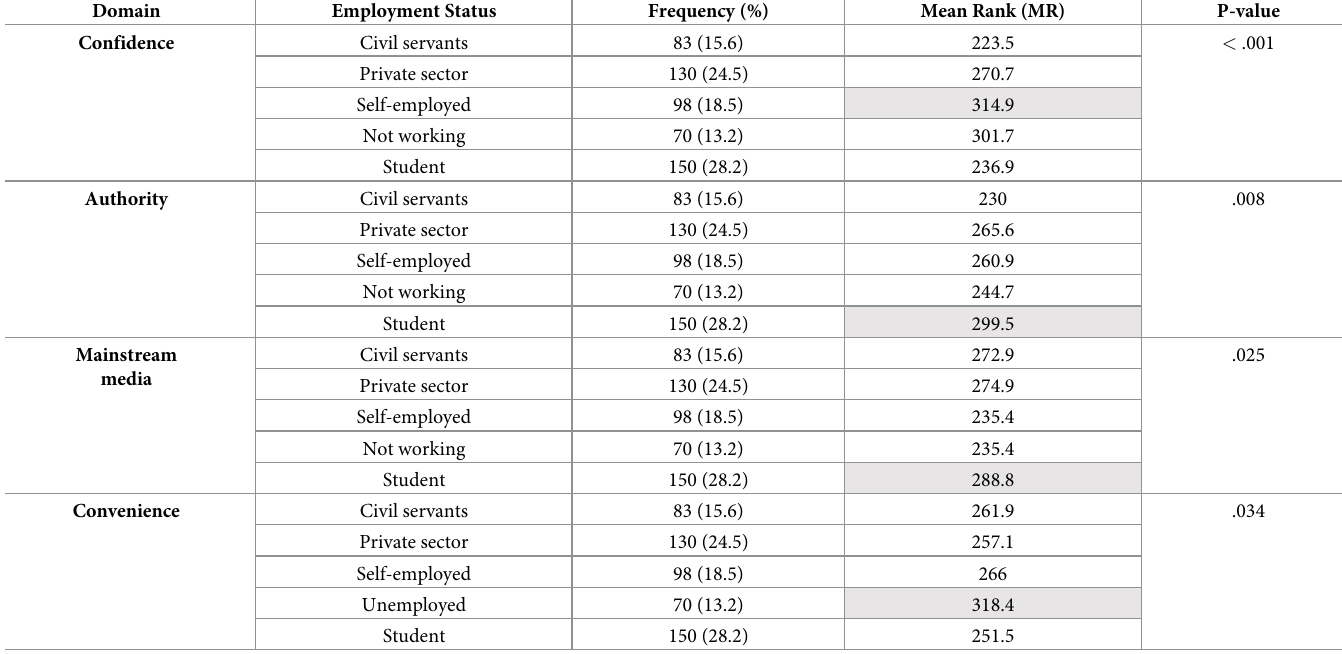
Table 9. Results of Kruskal-Wallis test for Cluster